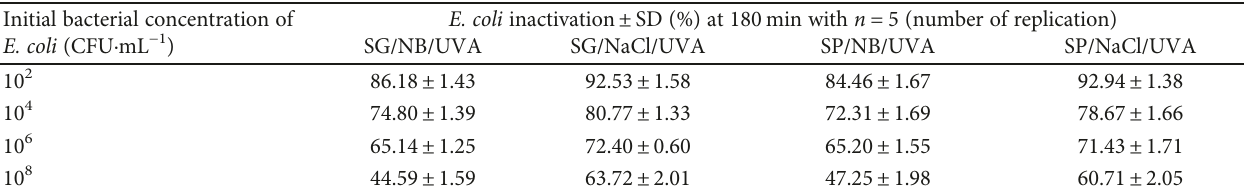
thin fi lms under UVA after 180 minutes given the various initial bacterial 2